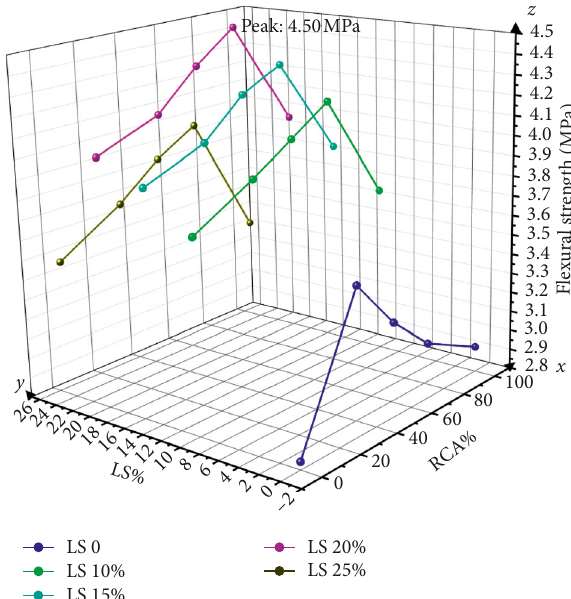
Figure 5: The effect of RCA and LS on the flexural